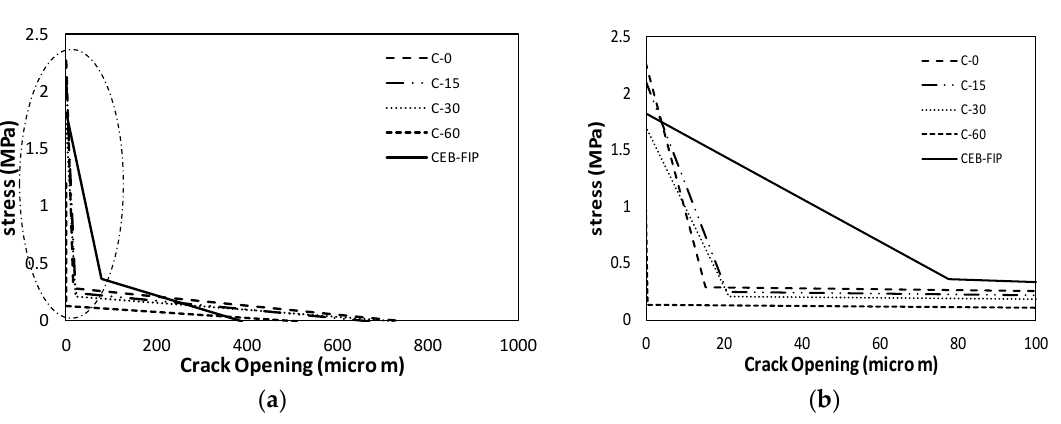
Figure 11. ( a ) Bilinear approximation of the softening curve for C type specimens; and ( b ) enlarged graph. Table 2. Results of fracture tests for (C type of specimens).